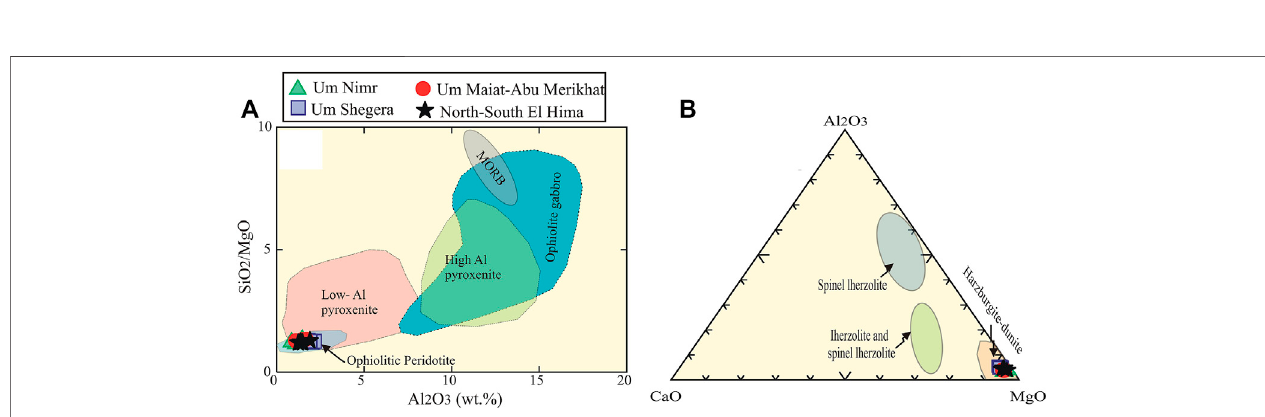
FIGURE 8 | (A) Al 2 O 3 against SiO 2 /MgO diagram of Bodinier and Godard (2003) and (B) CaO-Al 2 O 3 -MgO ternary diagram (Li et al., 2004).